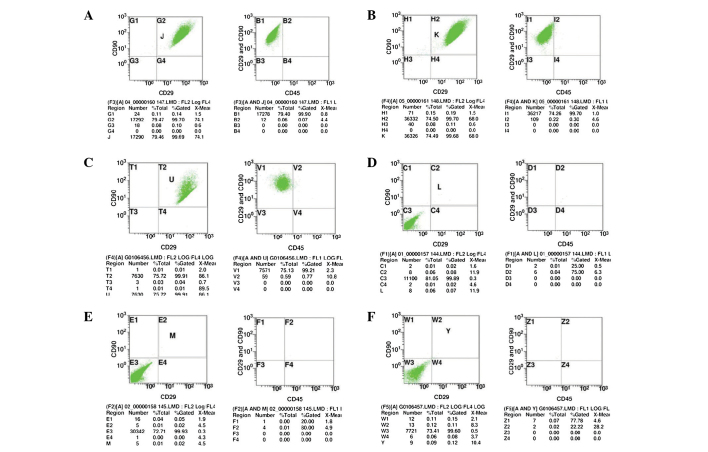
Flow cytometric analysis of New Zealand rabbit bone marrow mesenchymal stem cells labeled for cell-surface markers CD90+/CD29+/CD45−. The mesenchymal stem cells were grouped into (A-C) experimental group (n=3) and (D–F) control group (n=3). The experimental group was treated with 5 µl fluorescent antibodies (PE-CD29, PerCP/Cy5.5-CD90, FITC-CD45) and the control group was treated with 5 µl homotype fluorescent antibodies (PE-IgM, PerCP/Cy5.5-IgG1, FITC-IgG1), the cells were then incubated at room temperature in the dark for 30 min and flow cytometry was used to detect the surface molecules.